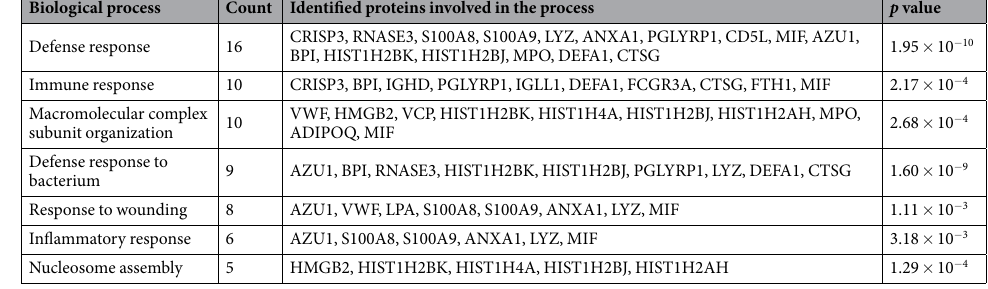
Table 1. Enrichment analysis of biological processes for up-regulated proteins in effusions. DAVID (version 6.7) was applied to functionally annotate enriched proteins, using the annotation category GOTERM_BP_FAT. Processes with at least five protein members and p values less than 0.01 were considered